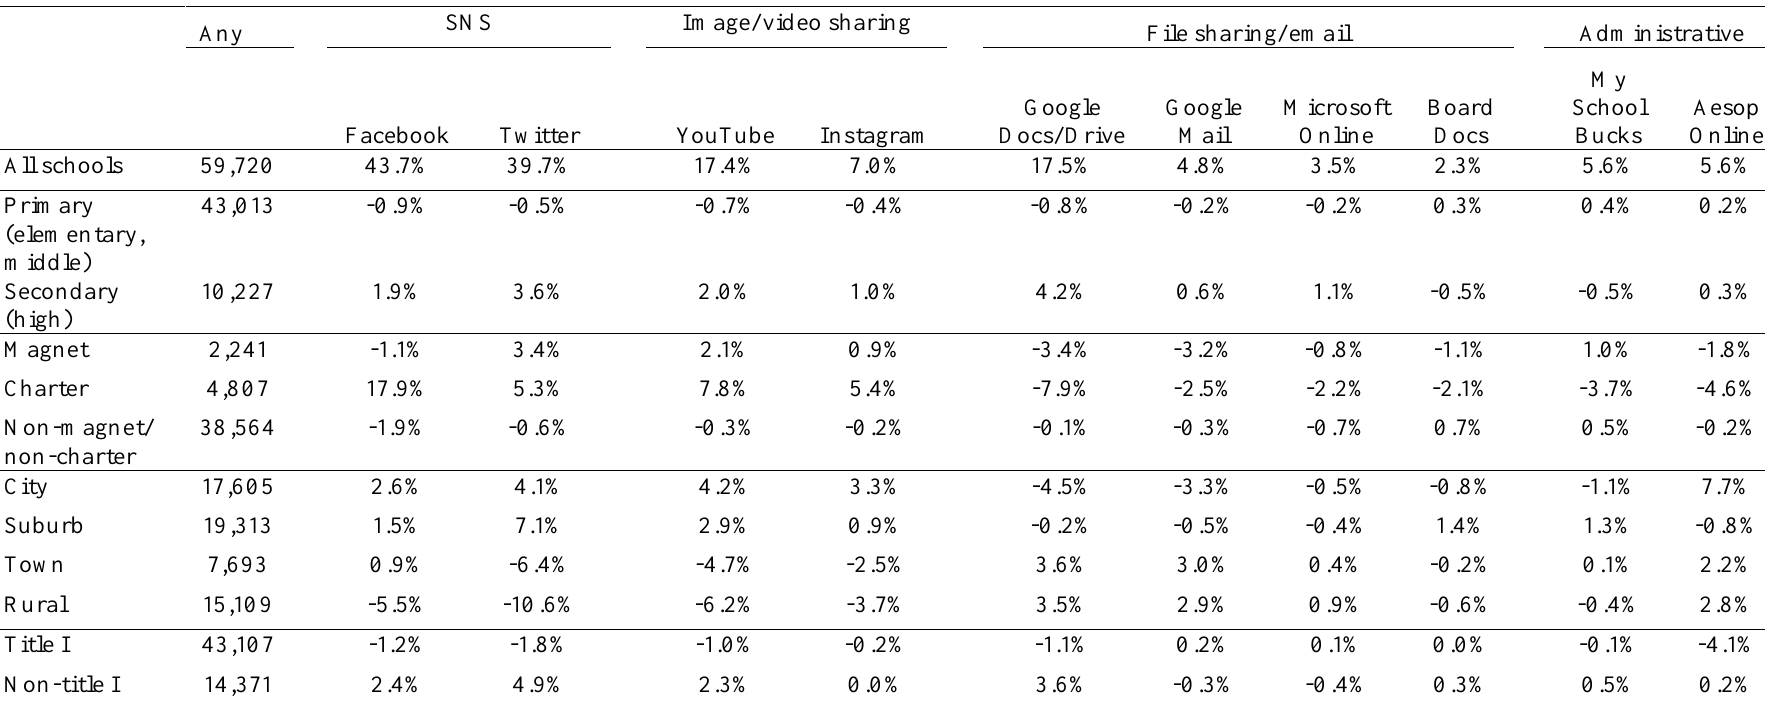
Table 5 Supplemental Service Adoption and Difference From Mean Based on School